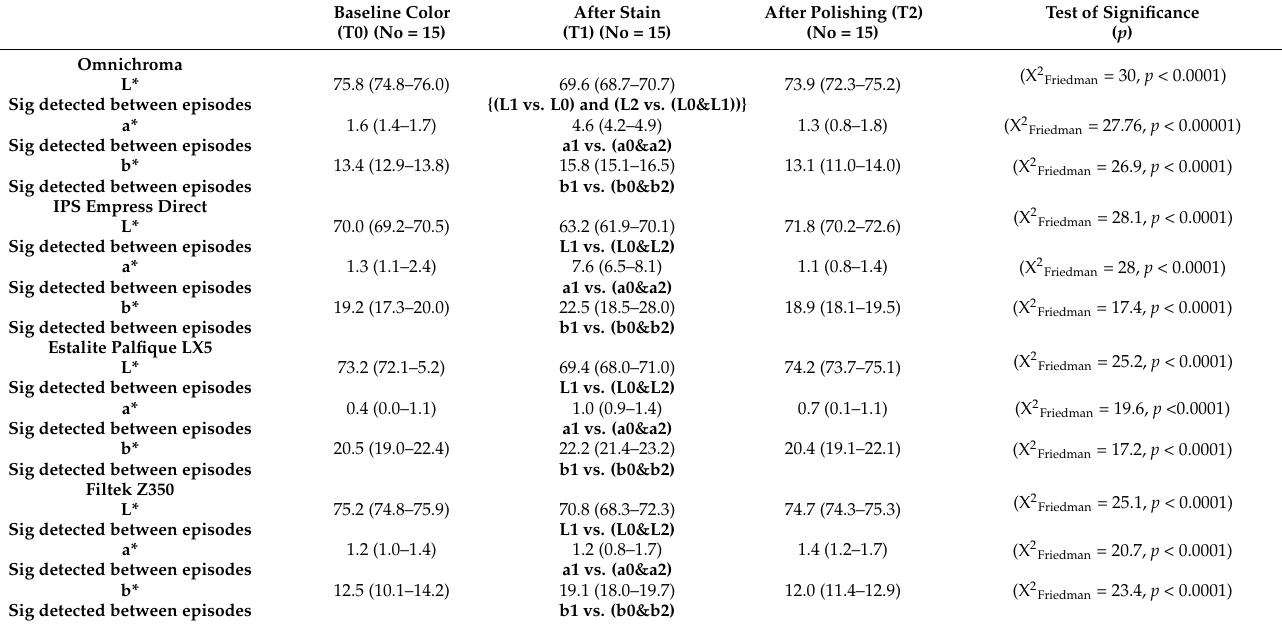
Table 2. Color-change parameters for resin composites at baseline (T0), after staining (T1), and after polishing